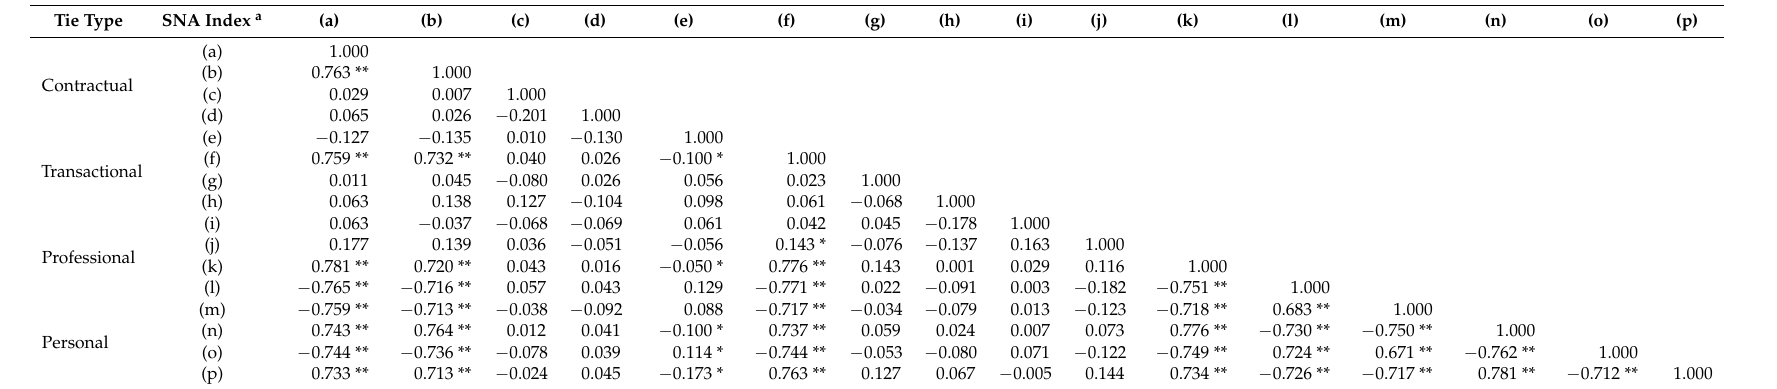
Table 4. Bivariate correlation